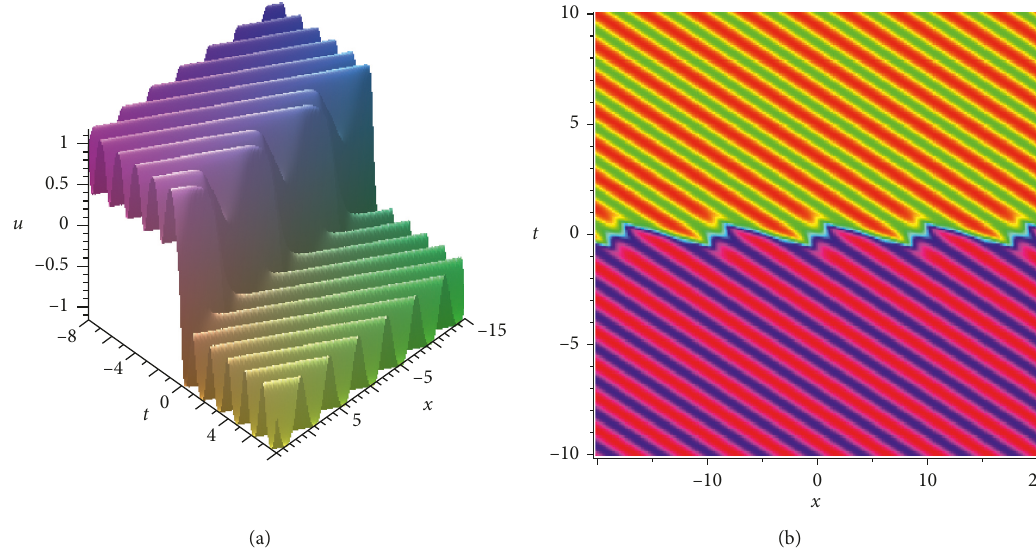
Figure 2: The interaction solution (40) with equations (51) and (52) and the parameters are fixed by (54): (a) the three-dimensional plot; (b) the corresponding density plot.